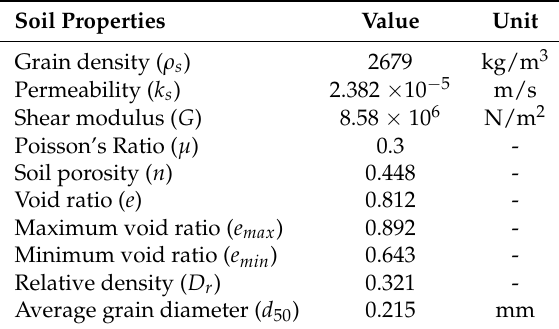
Table 3. Soil properties used in the